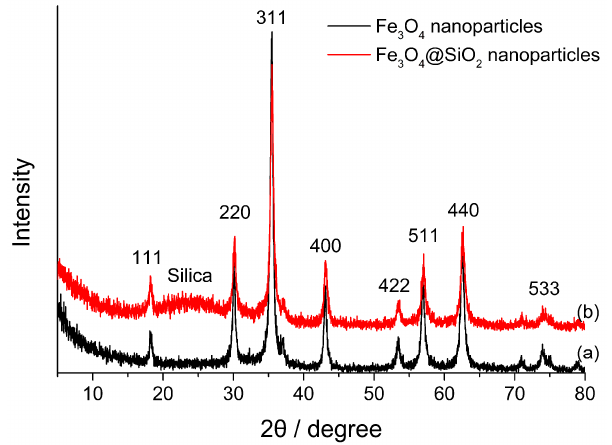
Figure 2. X-ray powder diffraction (XRD) patterns of (a) Fe 3 O 4 nanoparticles and (b) Fe 3 O 4 @SiO 2 nanoparticles.